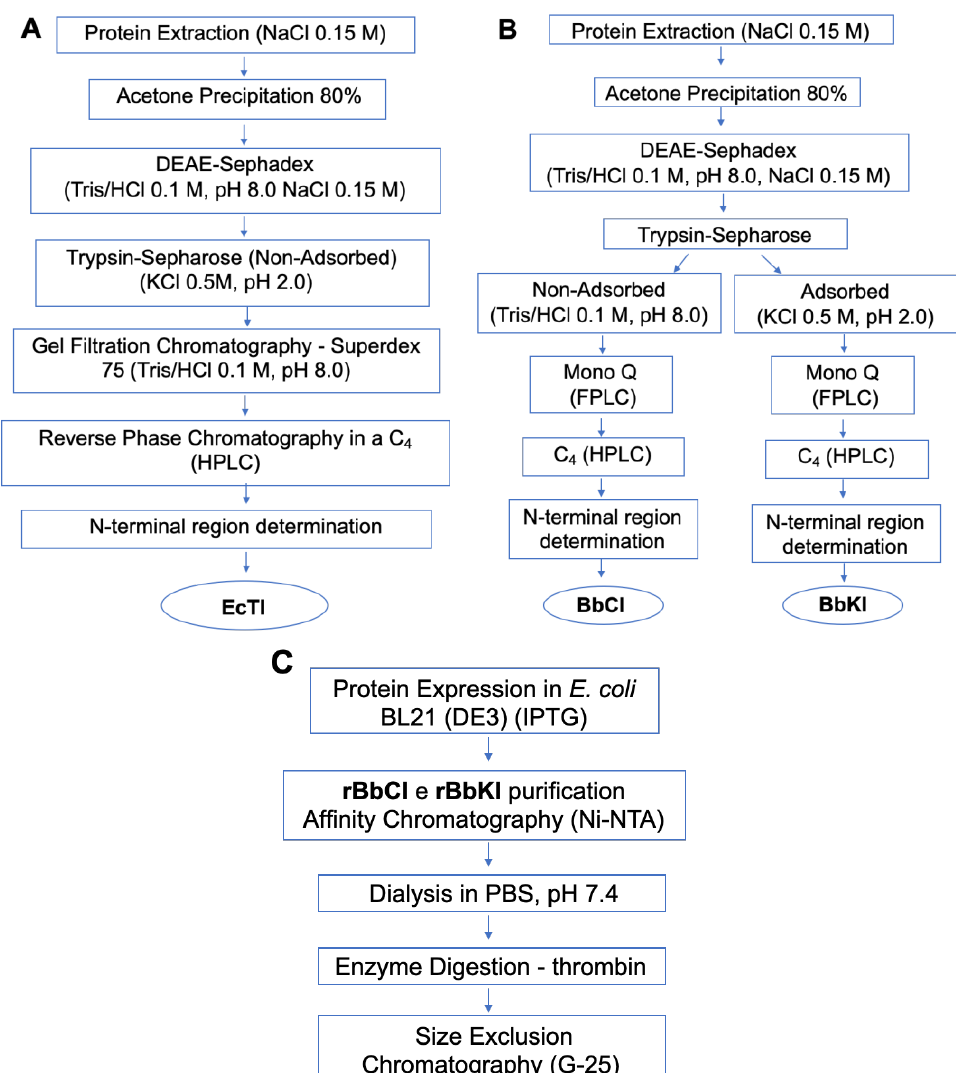
Figure 7. Purification scheme for ( A ) Enterolobium contortisiliquum trypsin inhibitor (EcTI), ( B ) Bauhinia bauhinioides cruzipain inhibitor (BbCI) and kallikrein inhibitor (BbKI), and ( C ) recombinant protein from BbCI (rBbCI) and BbKI (rBbKI).